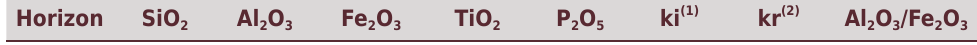
Table 6. Chemical composition and ki and kr molecular relationship for soil profiles in a toposequence in Lavandeira, TO,